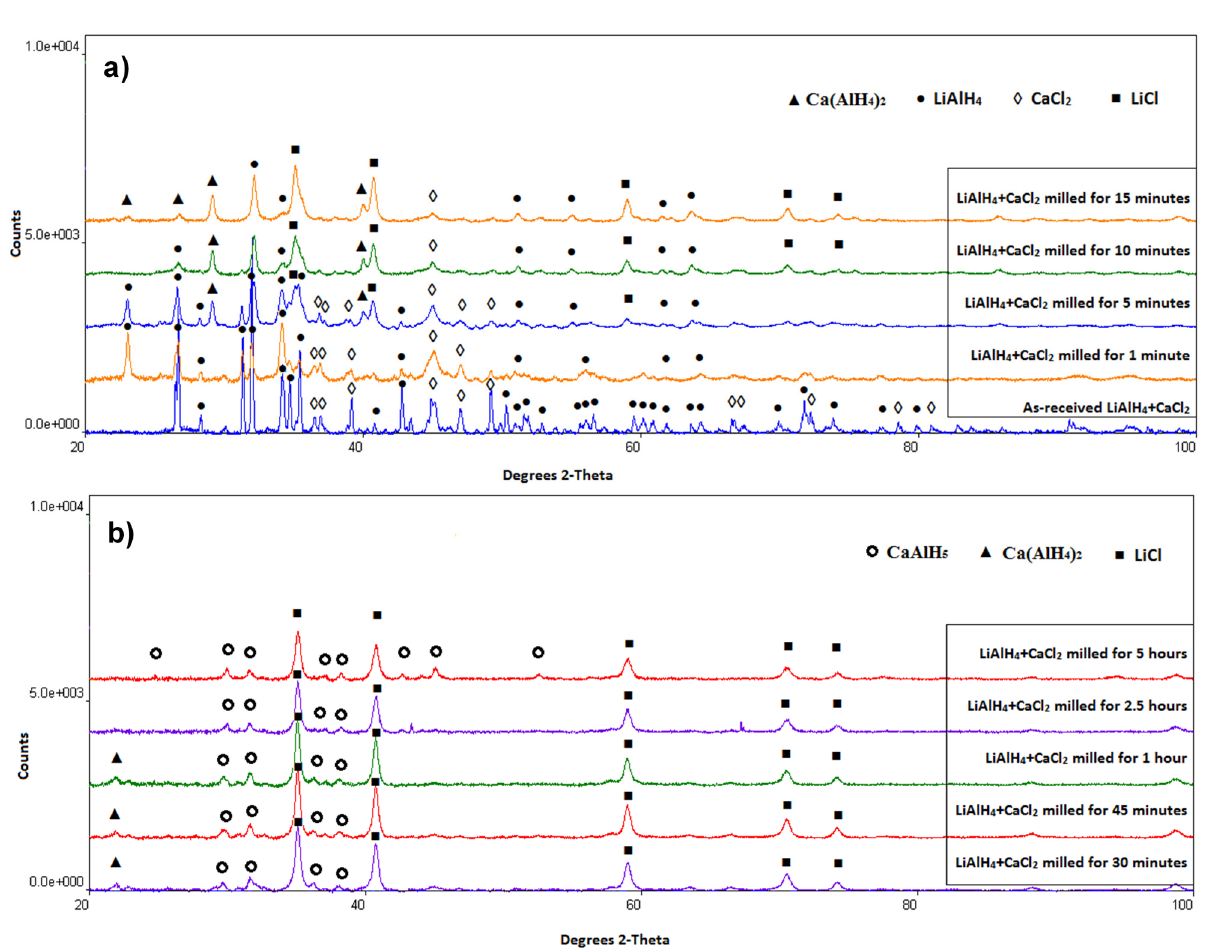
Figure 3. XRD patterns of the (2LiAlH 4 +CaCl 2 ) powders after varying milling durations. ( a ) as-received and milling up to 15 min; ( b ) milling from 30 min to 5